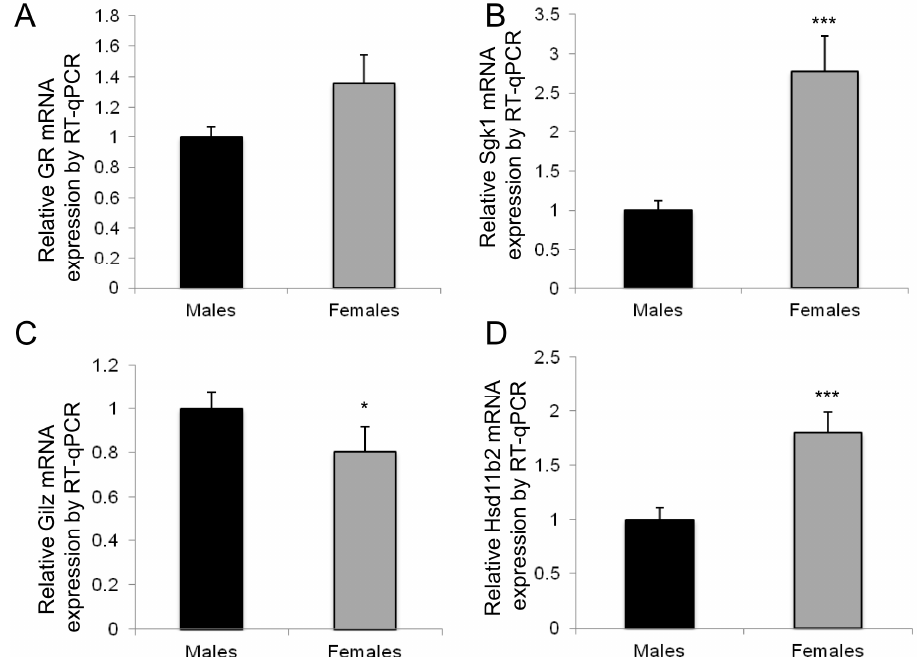
Figure 3. Sexual dimorphism in renal MRs, GRs, Hsd11b2 and several MR-regulated target gene expressions in adult (M3) mice in another independent series of 12 animals (6 males and 6 females) of a different strain (C57B6/129S). GRs ( A ); Sgk1 ( B ); Gilz ( C ); and Hsd11b2 ( D ) renal relative mRNA expressions in adult mice (M3: 3 months of age) were determined using RT-qPCR. Results, expressed as the ratio of attomoles of specific gene per femtomole of ribosomal 18S, normalized to the expression of male mice and arbitrarily set at 1, correspond to mean ± SEM of two independent reverse-transcriptions comprising at least 6 male and 6 female kidneys each. * p < 0.05, *** p < 0.001.